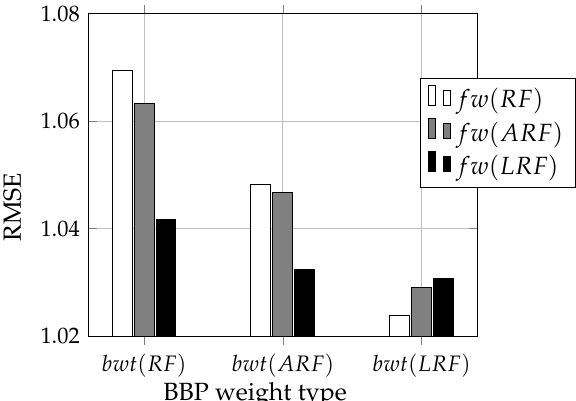
Figure 3. Comparison of MBA’s RMSE for Case